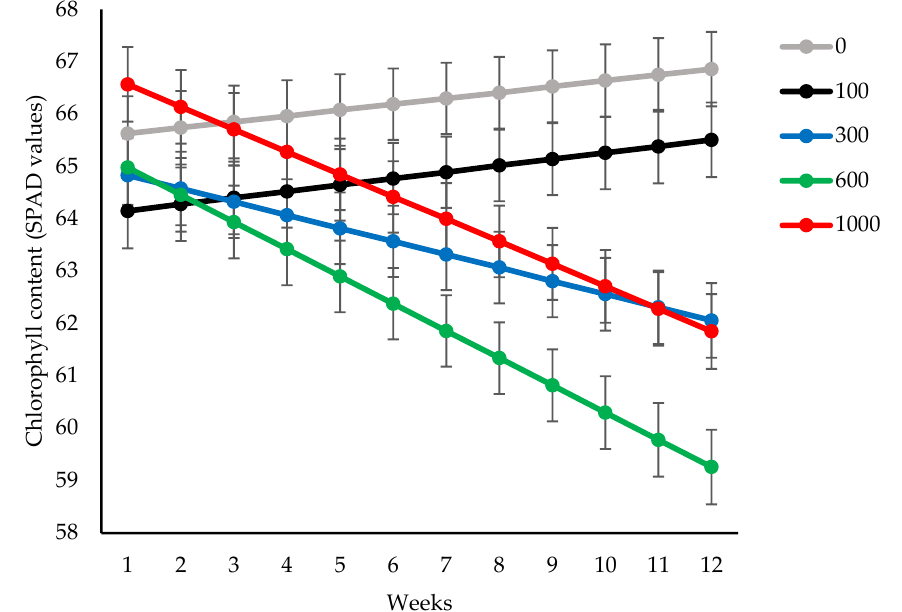
Figure 2. Effect of initial density of O. lybicus on chlorophyll measured by SPAD meter on date palm leaflets in the period of eleven weeks following insect release. Predicted means with standard error bars were derived by generalized linear mixed model analysis ( p < 0.001).